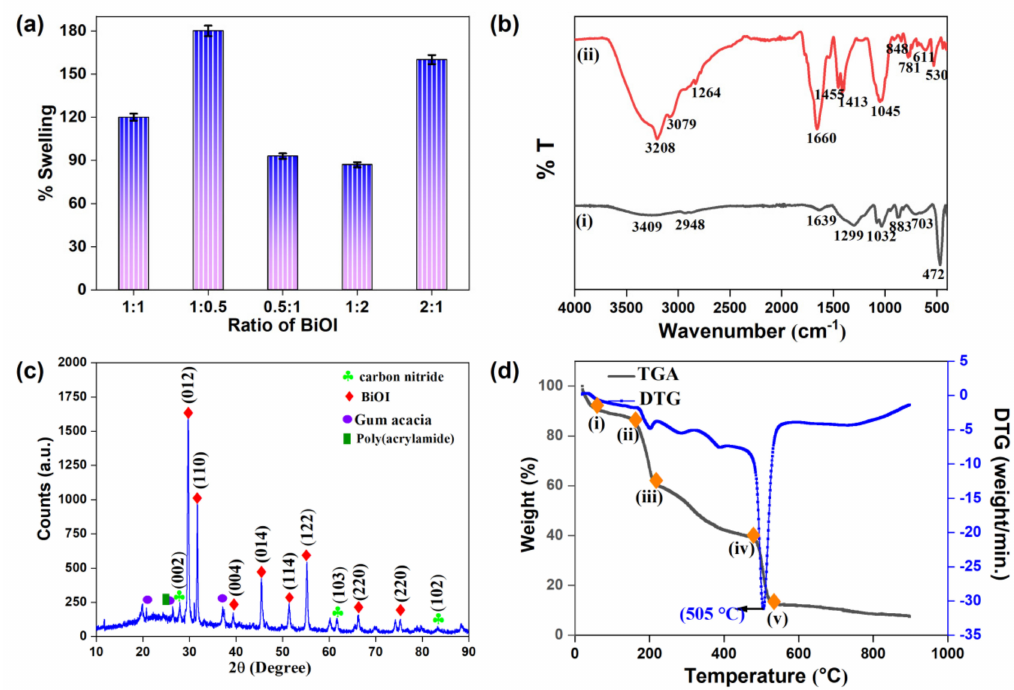
Figure 1. ( a ) The swelling capacity by varying the ratio of C 3 N 4 :BiOI after 24 h; ( b ) FTIR spectra of (i) BiOI and (ii) GA-cl-poly(acrylamide)@C3N4/BiOI nanocomposite hydrogel; ( c ) XRD; and